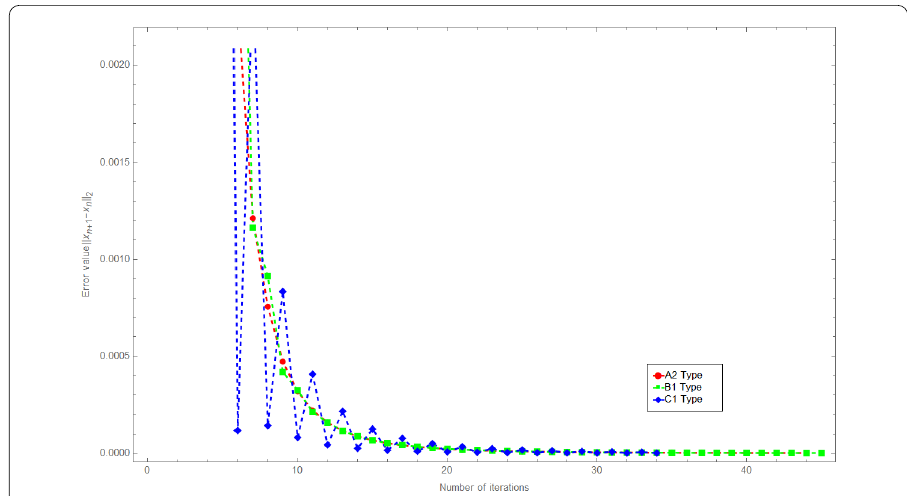
Figure 2 Convergence behavior of the error sequences {(cid:13) x n +1 – x n (cid:13) 2 } for all the best choice types A2, B1, and C1 in Example